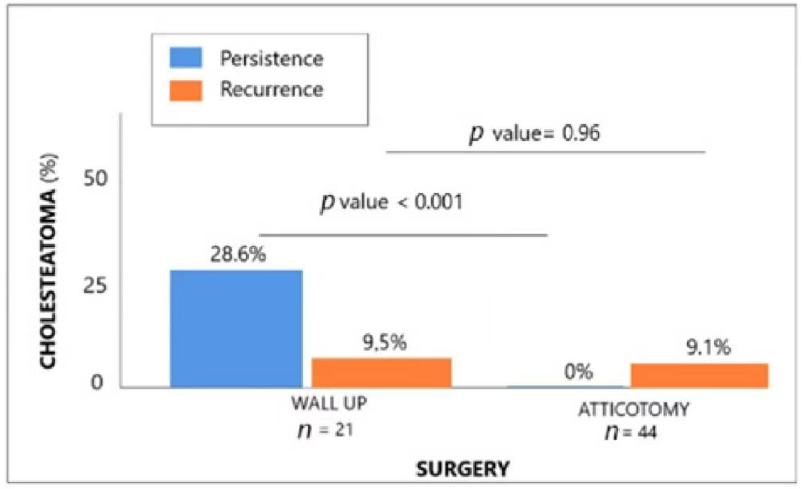
Figure 5. Comparison of recurrence and persistence of cholesteatoma rates according to type of surgery.